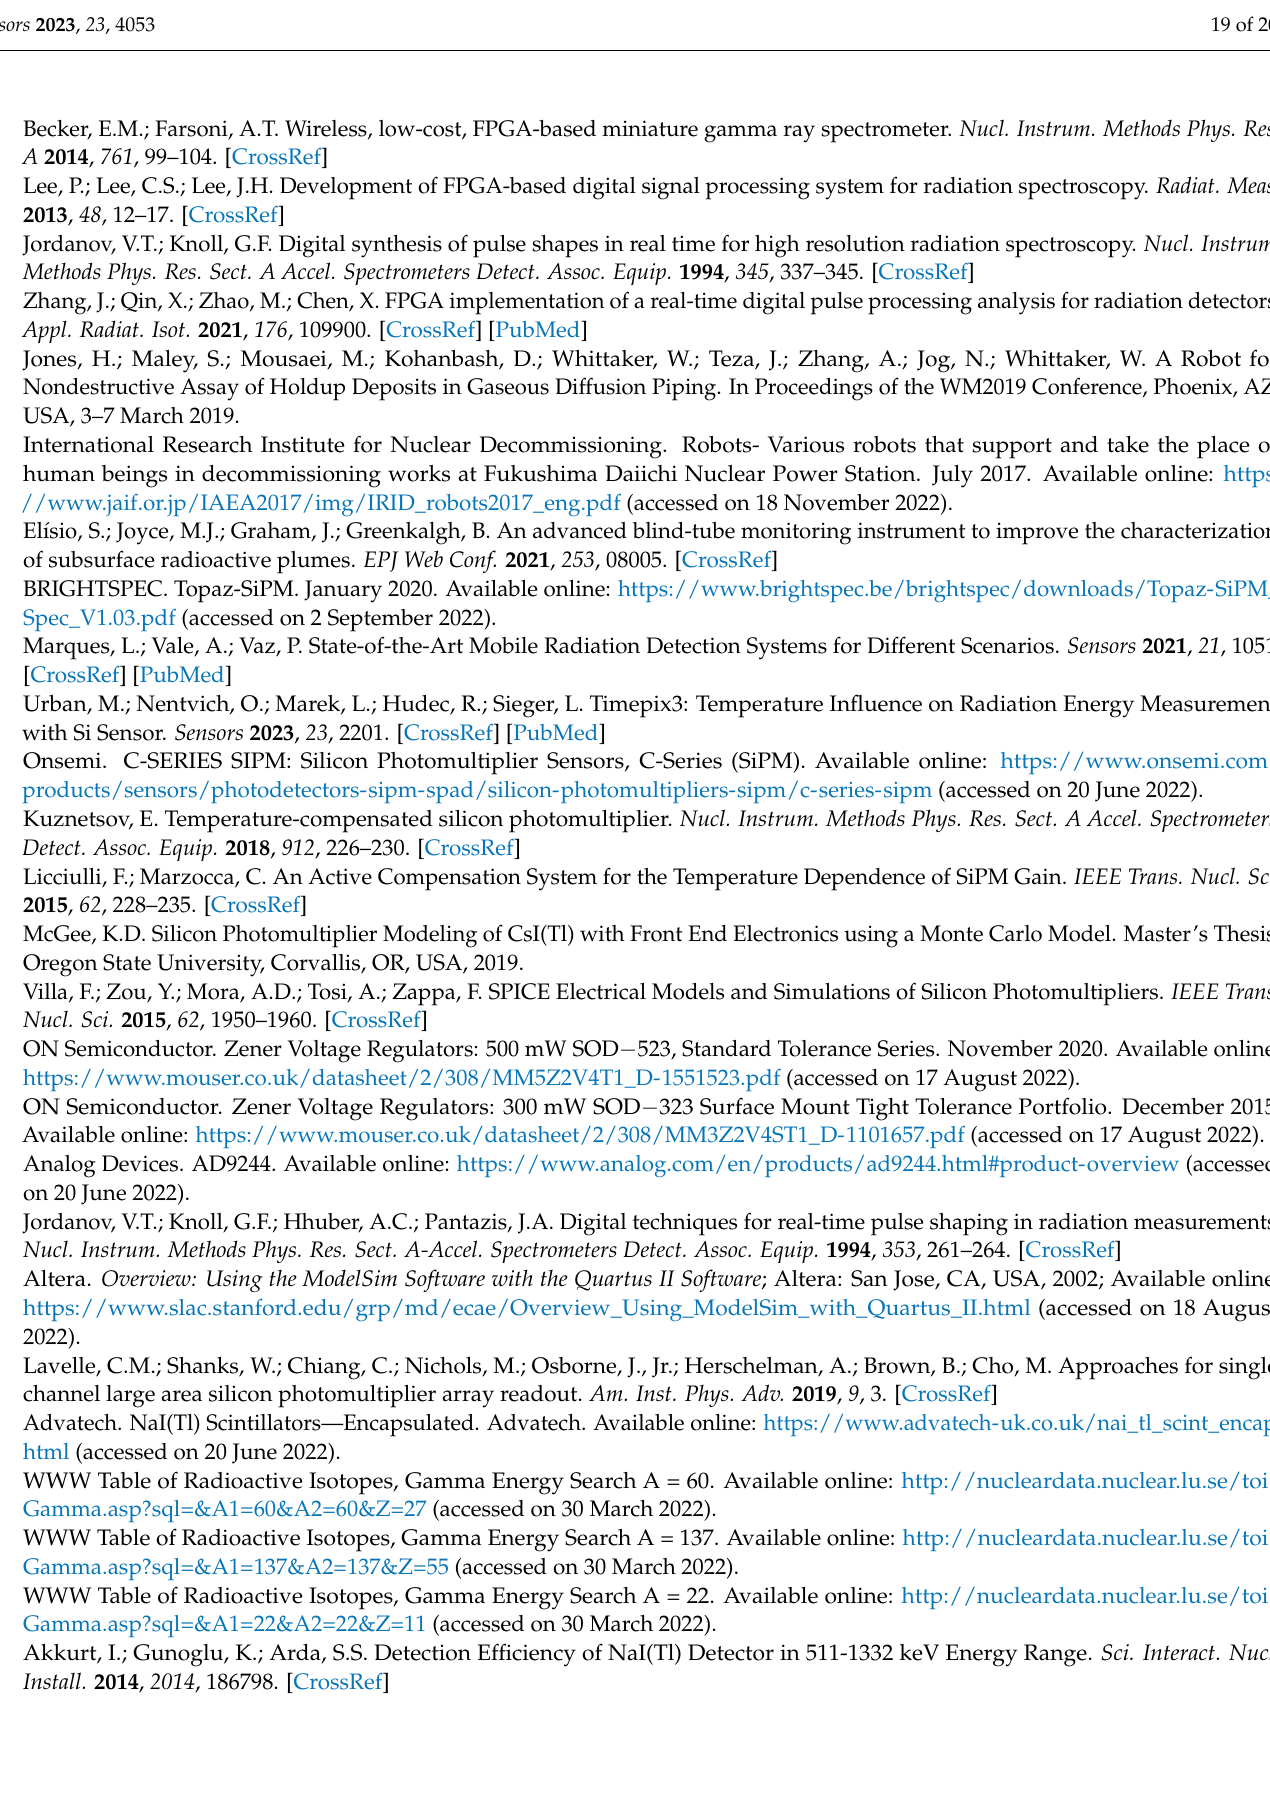
WWW Table of Radioactive Isotopes, Gamma Energy Search A = 60. Available online: http://nucleardata.nuclear.lu.se/toi/ Gamma.asp?sql=&A1=60&A2=60&Z=27 (accessed on 30 March 2022). WWW Table of Radioactive Isotopes, Gamma Energy Search A = 137. Available online: http://nucleardata.nuclear.lu.se/toi/ WWW Table of Radioactive Isotopes, Gamma Energy Search A = 22. Available online: